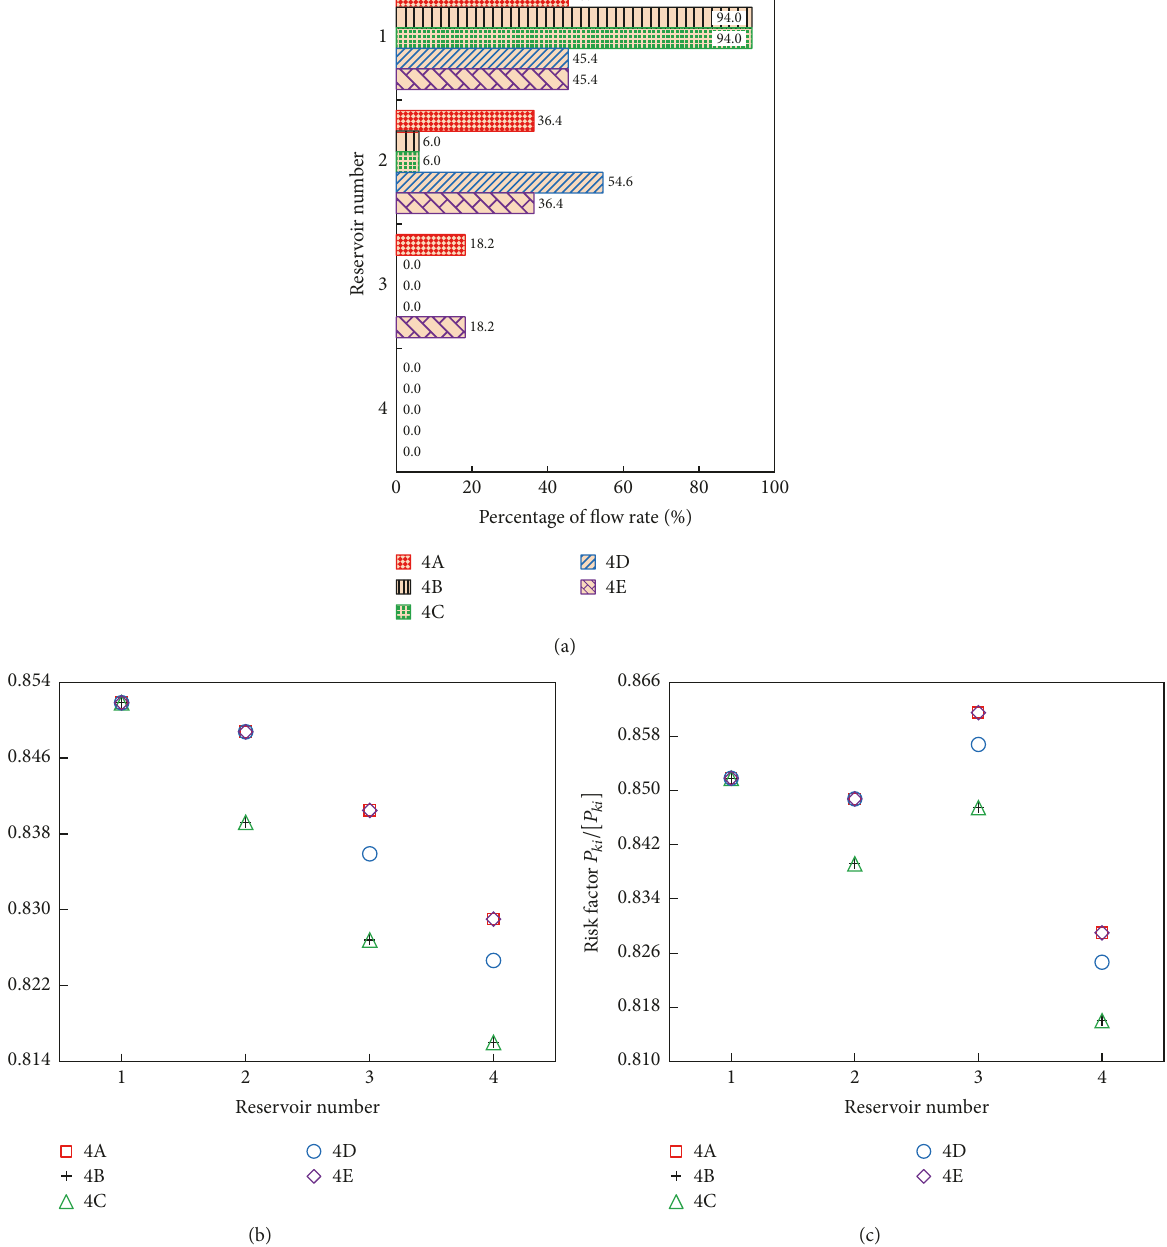
risks of the reservoirs for each case agree well with each